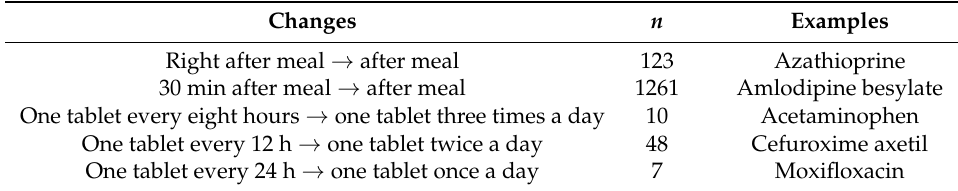
Table 1. Simplified medication regimens and examples.